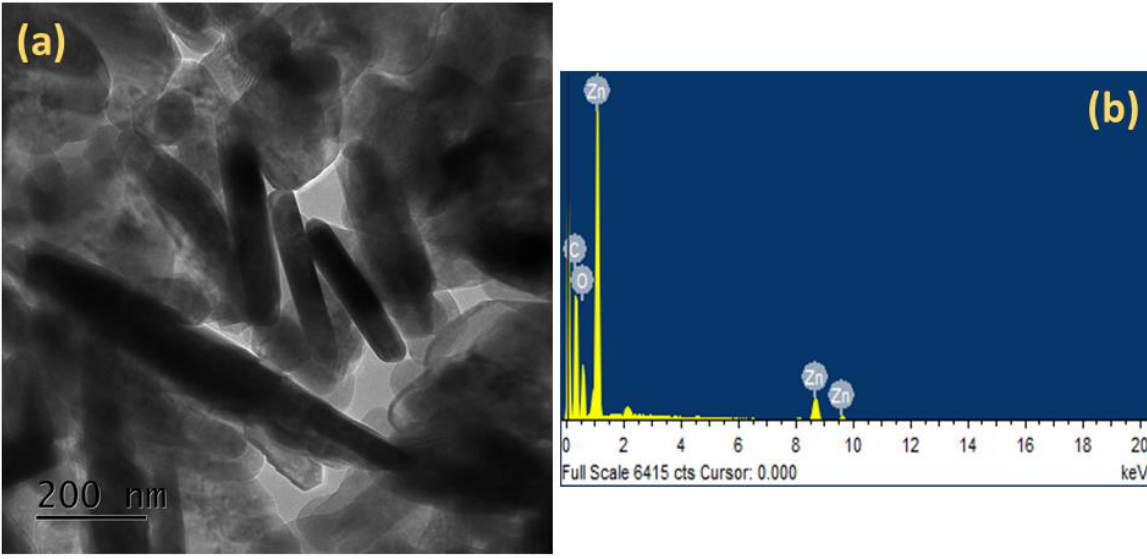
Figure 6. ( a ) TEM image, ( b ) HRTEM image, and ( c ) EDX spectrum of ZnO prepared at 85 °C.